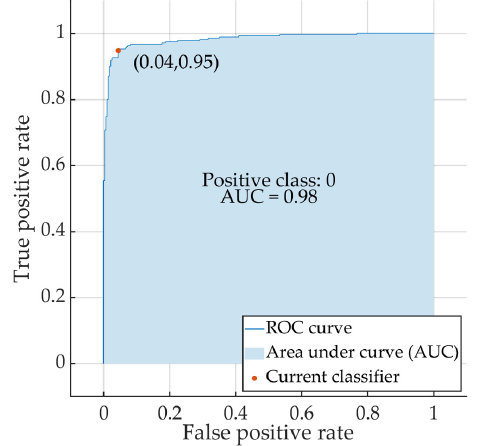
Figure 7. The ROC plot of the constructed SVM model.